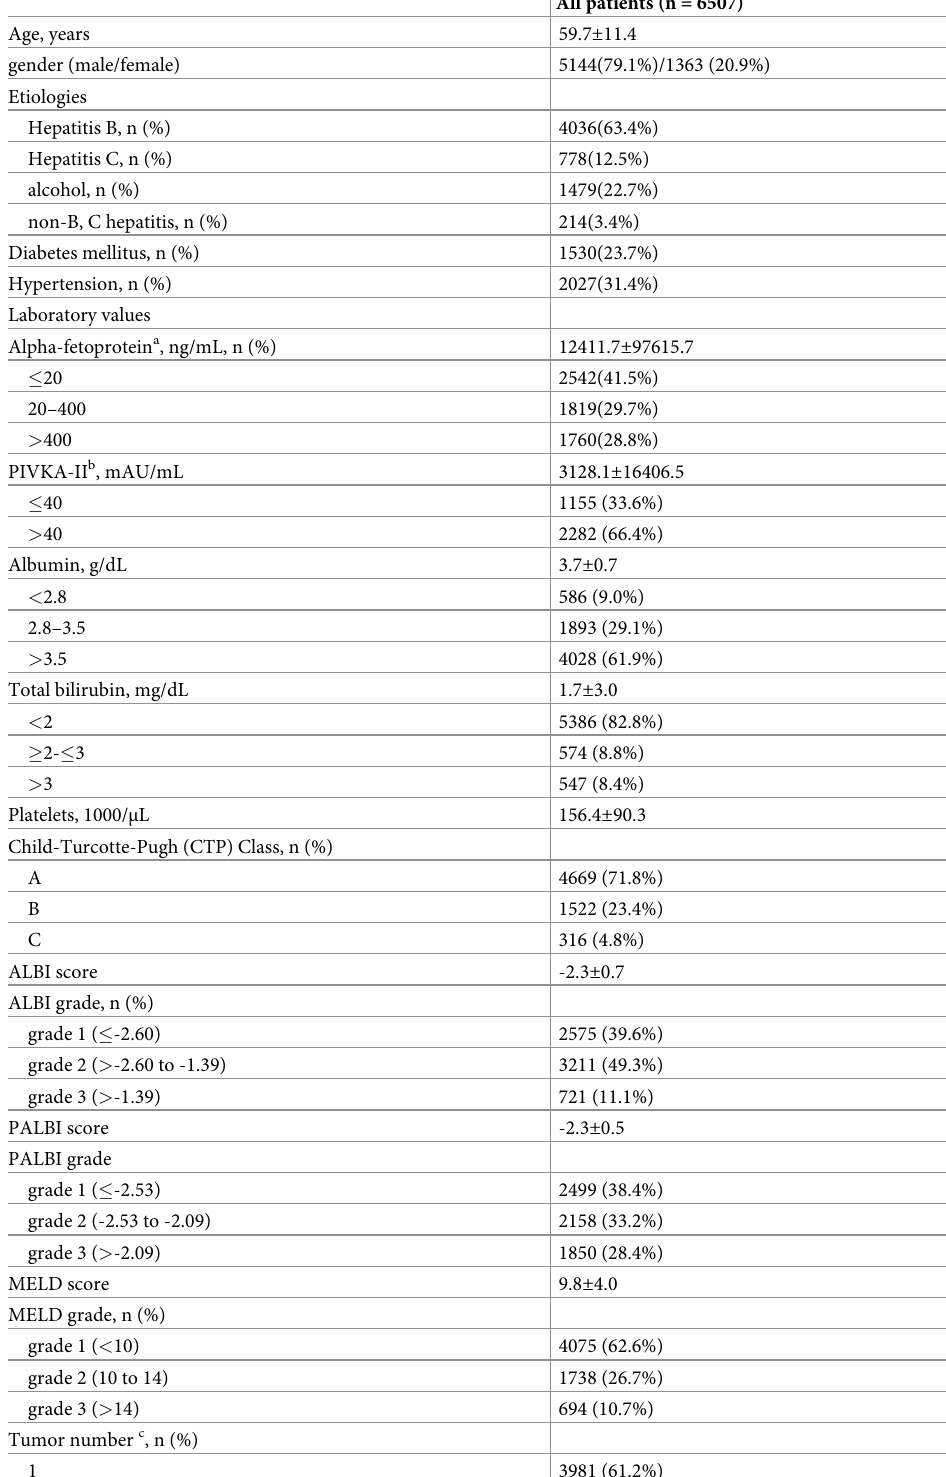
Table 2. Baseline characteristics of included